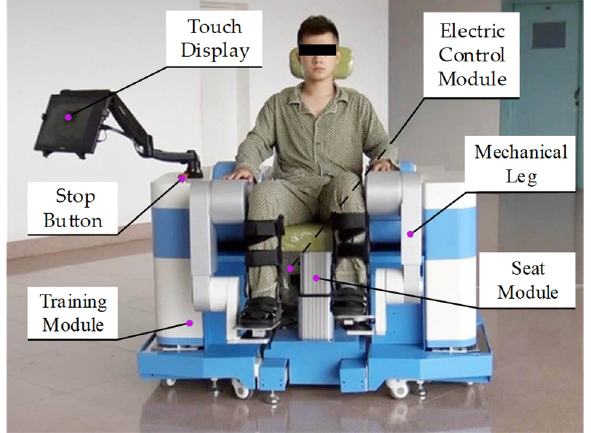
Figure 1. Structure of